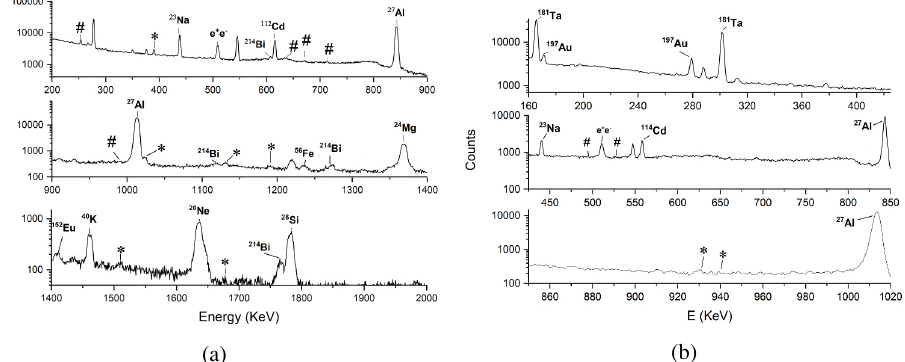
Figure 2: (a) Horizontal split–view (0.2–2.0 MeV) of a typical in–beam spectrum for the reaction p + 112 Cd. Transitions to the gs of 113 In are marked with an ( ∗ ). Transitions to the isomeric state are marked with (#). Additional photopeaks arising from background radiation or other beam induced reactions are also marked. (b) Horizontal split–view (0.16–1.02 MeV) of a typical in–beam spectrum for the reaction p + 114 Cd.